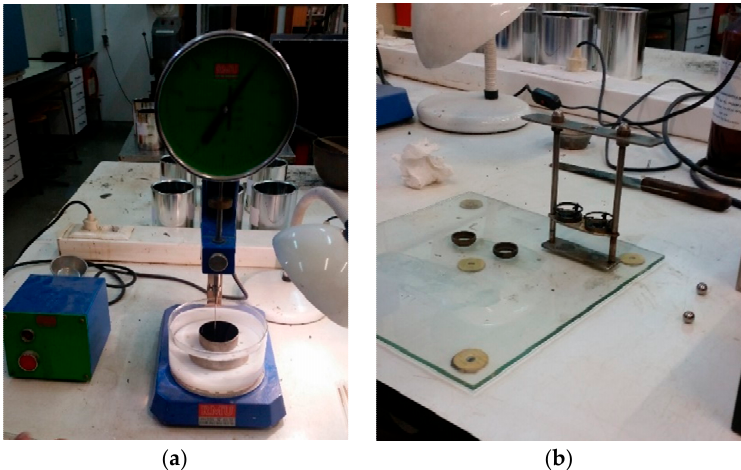
Figure 2. Test equipment to characterize the bitumen. ( a ) Needle penetration test; ( b ) Softening point test. Table 3. Results of the bitumen